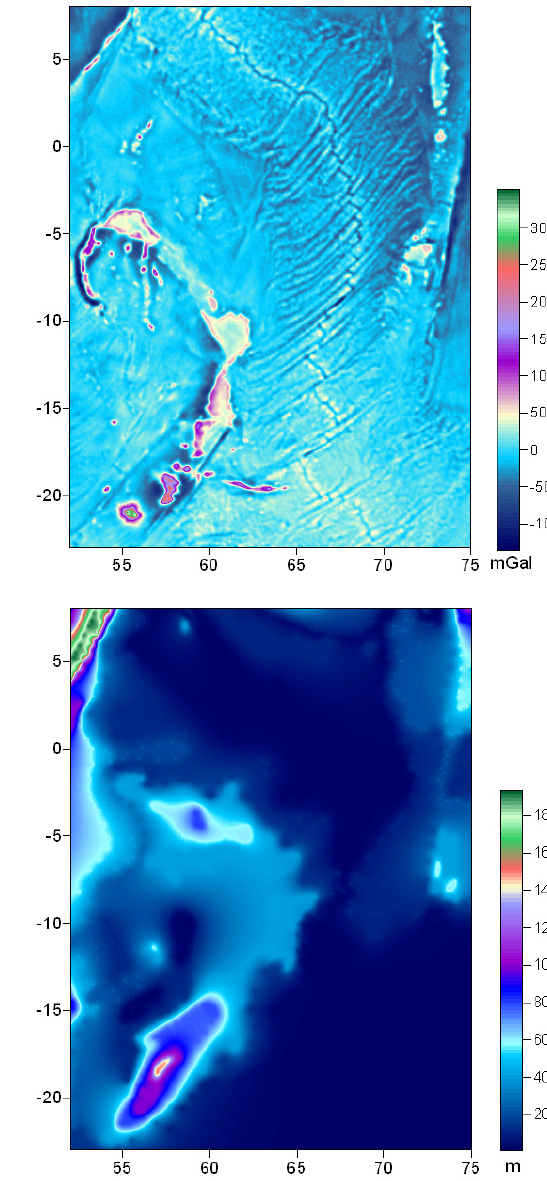
Figure 2. The maps of the study region. (a) Bathymetry map. (b) Free-air gravity map. (c) Bouguer gravity map. (d) Sediment thickness